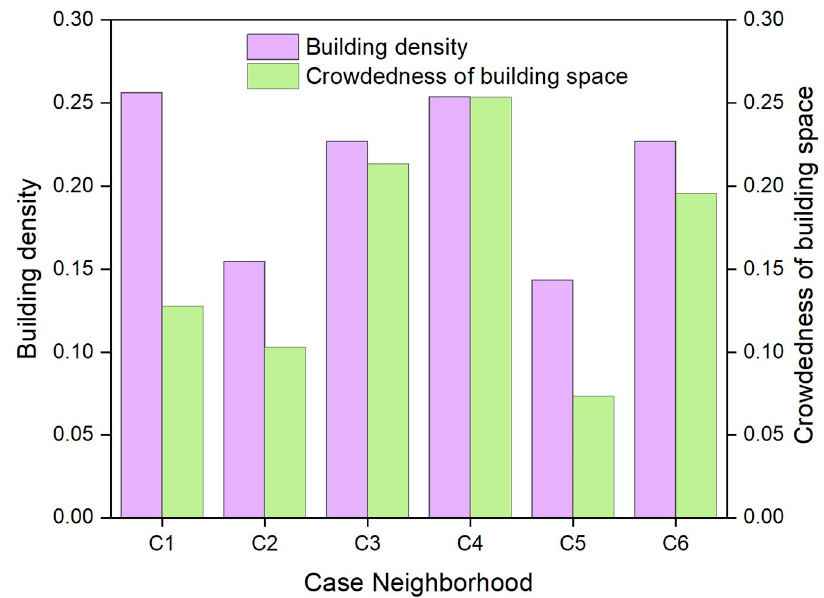
Figure 6. Landscape diversity and its parameters of the six case neighborhoods.